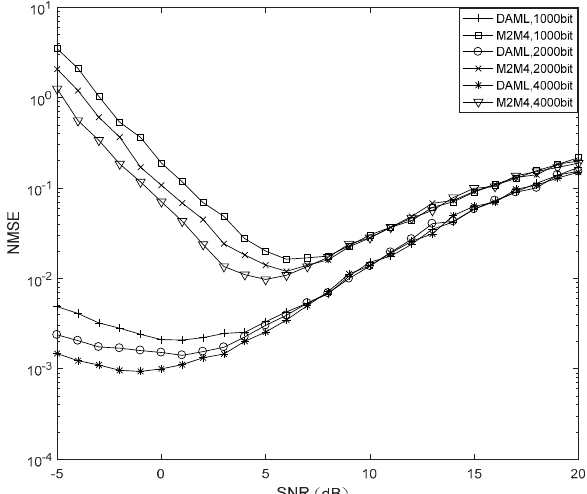
Figure 6. NMSE comparison of DA ML and M 2 M 4 in different lengths of information.